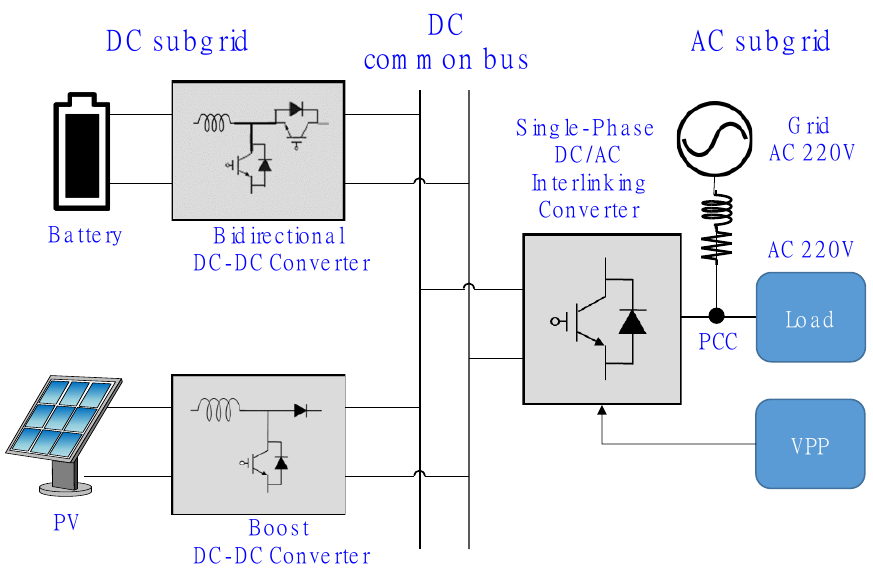
Figure 1. The architecture of the proposed AC/DC-interlinked hybrid microgrid.